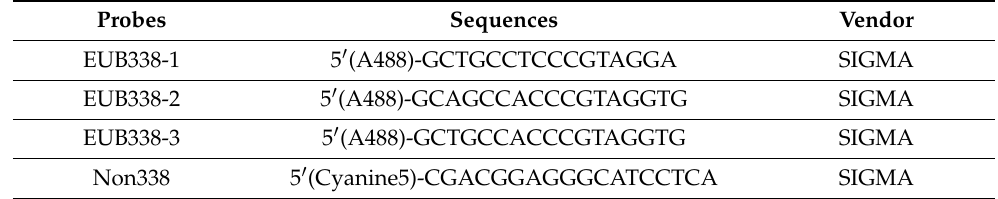
Table 2. Sequences of probes used for FISH